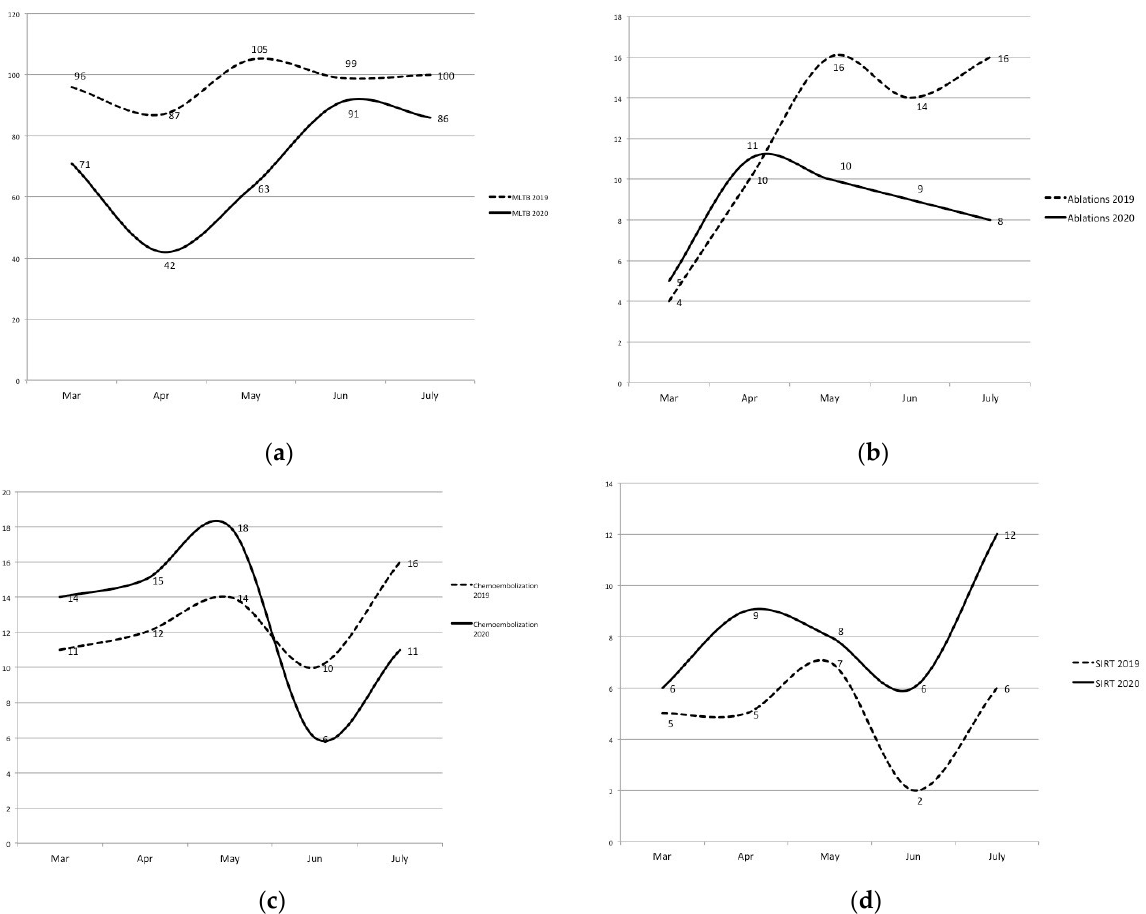
Figure 1. Liver oncologic activity between March and July 2019 and 2020: number of patients discussed at MLTB ( a ), ablations ( b ), transarterial chemoembolizations ( c ) and SIRT ( d ).